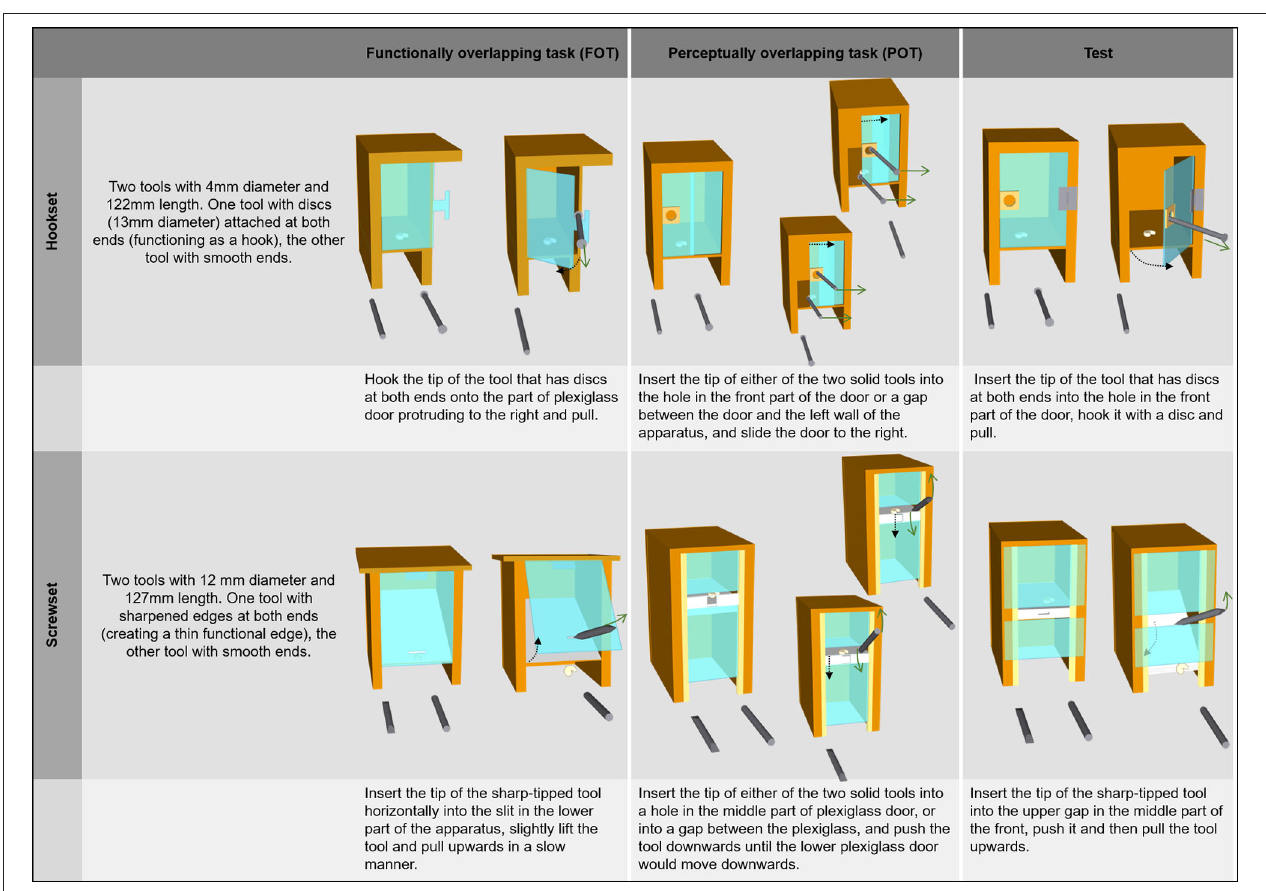
FIGURE 1 | Schematic overview of tasks and required actions. Shown are initial setup for each task and end state after opening. Description of required actions are listed below the schematics. For the perceptually overlapping tasks solutions with either tool and different techniques are provided. Dotted arrows indicate movement direction of relevant apparatus parts, whereas solid arrows show required movement of